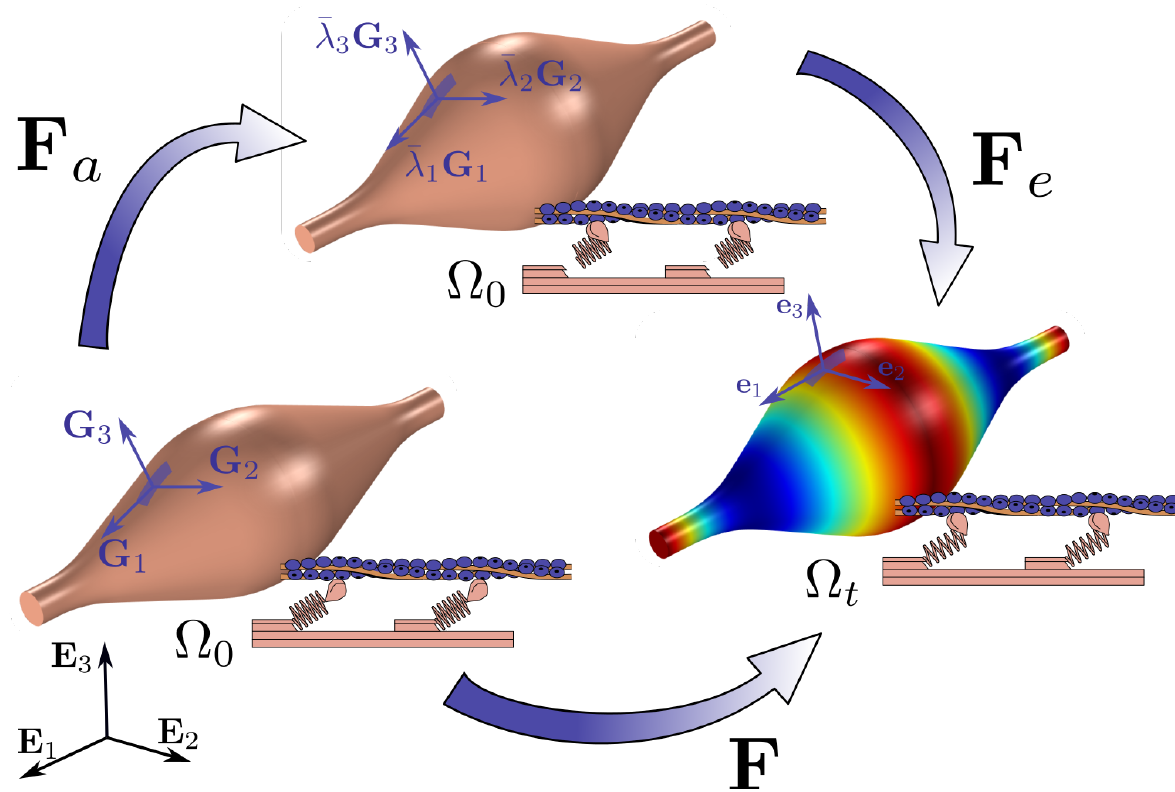
Figure 1. Illustration of the contraction process modelled as two fictitious steps. G i vectors located at a point X in a muscle fiber in the initial configuration Ω 0 transform into new vectors ¯ λ i G i by the active contraction F a . The intermediate step is associated with the relative motion of the protein filaments due to cross bridges power stroke. In the final step, the cross-bridges are deformed by F e to restore the compatibility of the deformed configuration Ω t